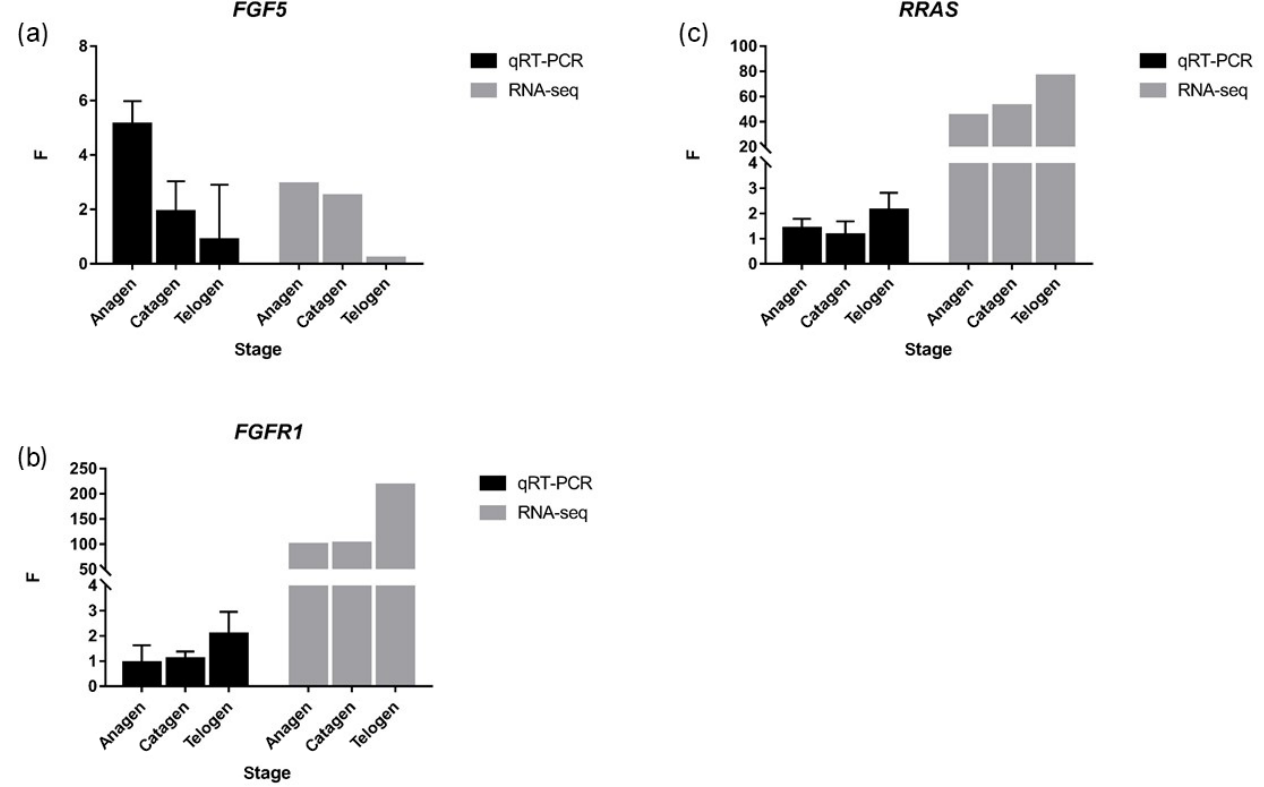
Figure 4. FGF5 , FGFR1 and RRAS were detected by qRT-PCR, and the trend was similar to RNA-seq. ∗∗ p value<0.01, ∗ p value<0.05.